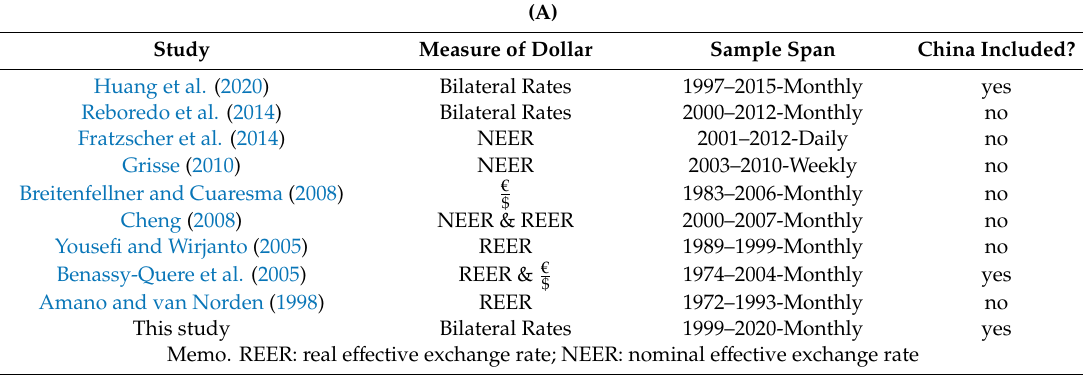
Table 1. ( A ) Design Characteristics of Selected Studies (by publication date). ( B ) Reported Statistical Tests of Selected Studies (by publication